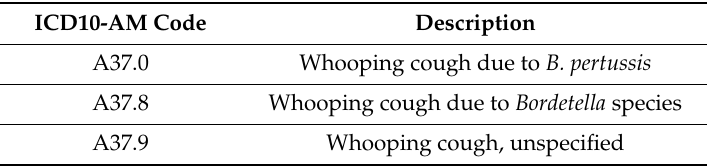
Table 3. ICD10 AM diagnostic codes for